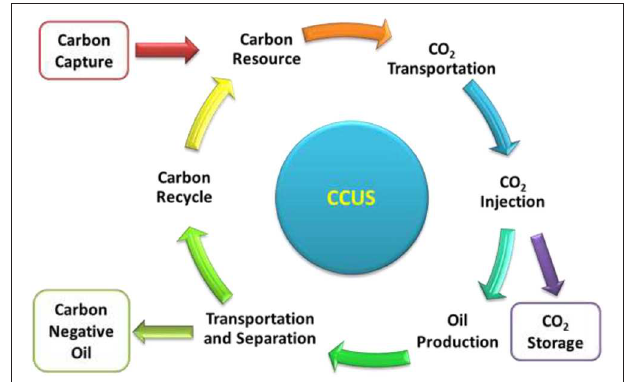
FIGURE 1 | Whole chain process of a CCS-EOR